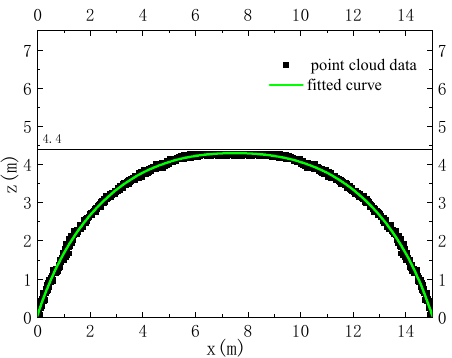
Figure 25. Fitting curve of section a-a.